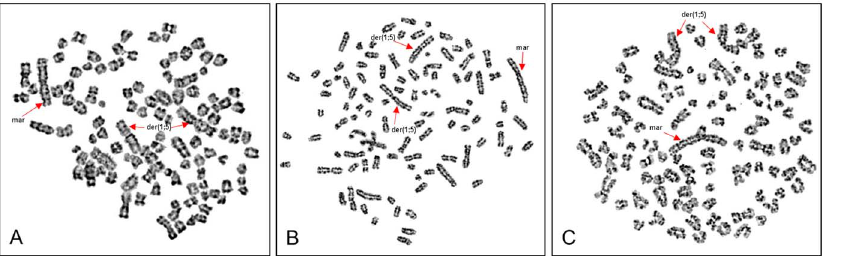
Figure 7. Cytogenetic analyses. Metaphase spreads derived from CT1258 (A), CT1258-EGFP (B) and CT1258-EGFP-HMGA2 (C) cells after GTG- banding. The arrows indicate the centromeric fusions between the canine chromosomes 1 and 5 (der(1;5)) and a large bi-armed marker (mar) consisting of material from chromosomes 1 and 2 being characteristic for the CT1258 cell line.